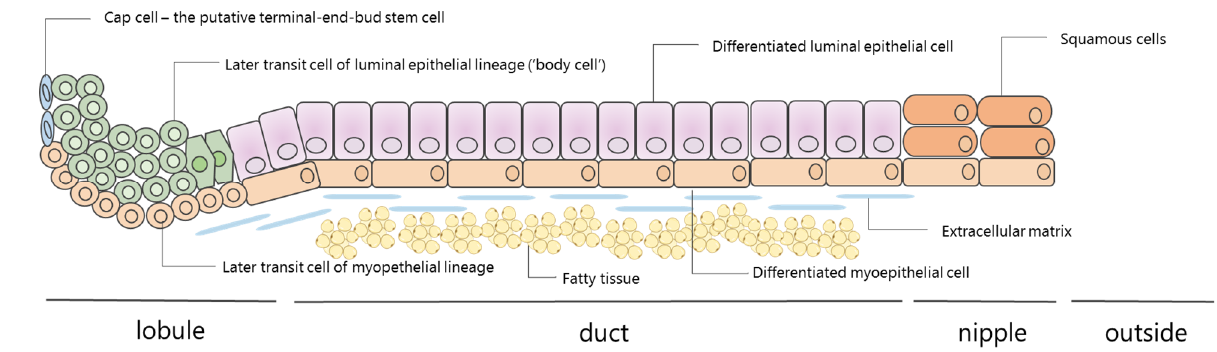
Figure 2. The mammary lobular–ductal system: cellular composition of the lobule, duct, and nipple (half linear representation). The breast contains around 5–12 mammary lobulo–ductal systems that start at the terminal end-bud and reach the nipple. Several lobulo–ductal structures can come together, leading to branching of this system into common ducts that end in the nipple. The mammary duct is composed of an outer layer of myoepithelial cells and an inner layer of luminal epithelial cells. At the end, near the nipple, there is a transition to squamous cells. Nipple aspirate fluid is probably produced by the inner luminal layer. The cap cells can take on either a myoepithelial lineage or a luminal epithelial lineage and therefore are thought to be multipotent stem cells. This scheme is adapted from Smalley and Ashworth [29] and Jakub et al. [30].